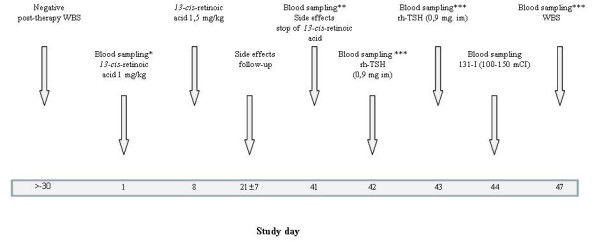
Study design. Radioiodine non-avid disease was confirmed by a negative post-therapy whole-body scan plus radiological imaging. Study day scale is not drawn proportionally. RAI, radioiodine treatment; rxWBS, post-therapy whole-body scan (* TSH, Tg, rTg, morphology, transaminase, cholesterol, creatinine. ** morphology, transaminase, cholesterol, creatinine, in 20 patients also TSH, Tg, rTg. *** TSH, Tg, rTg)